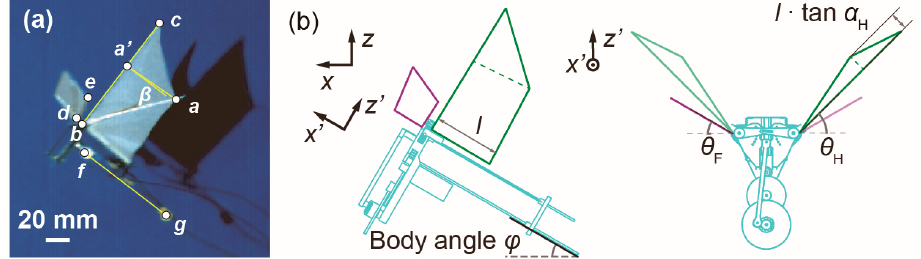
Figure 3. ( a ) Tracking points of the ornithopter in the obtained high-speed camera image; ( b ) Definition of the body angle and flapping angles.